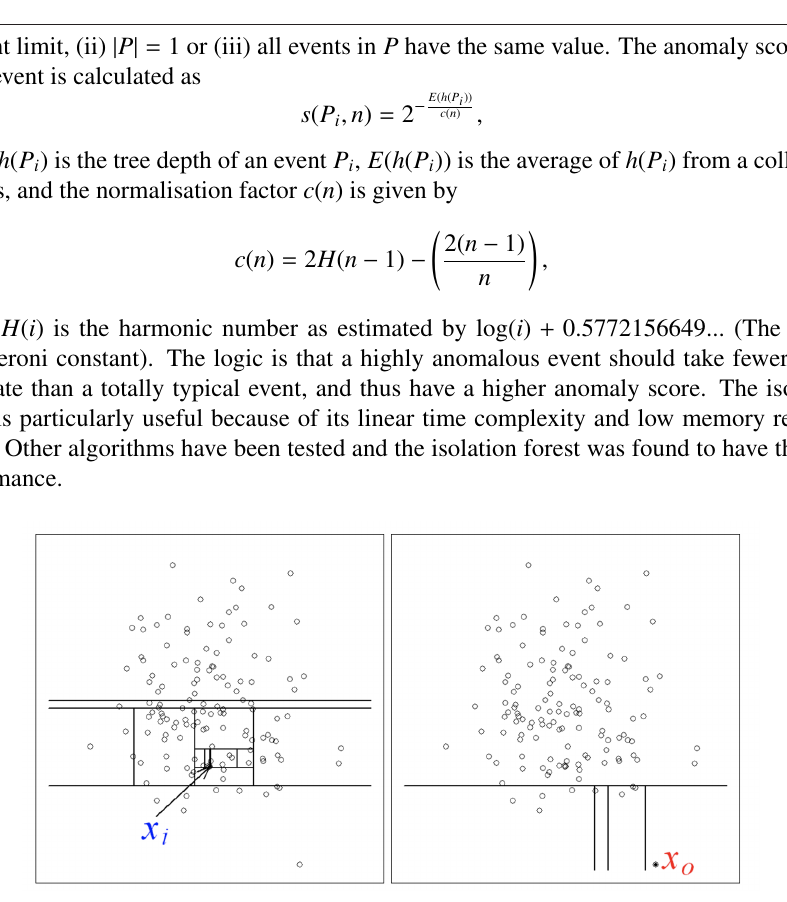
Figure 1. A visual representation of the logic of the isolation forest algorithm. The blue point x i is quite typical of the dataset and thus requires more slices to isolate, compared to the red point x o which is more anomalous and thus requires fewer slices to